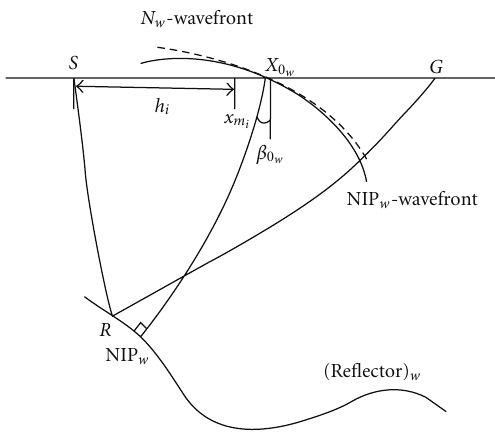
Figure 13: CRS parameters for a given source-receiver pair around a central ray at x 0 w